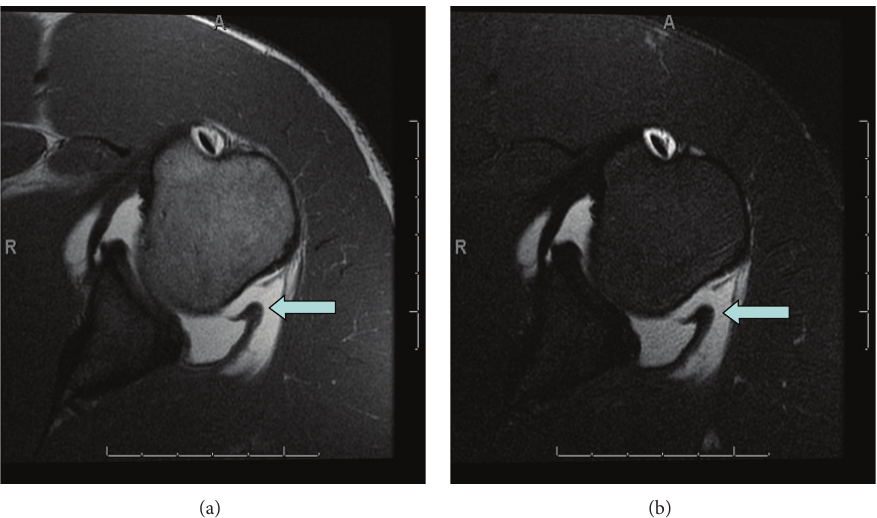
Figure 7: Case 7. Axial T1 and fat saturated T2 images demonstrate posterior band of IGL with thickening and retraction of ligament (arrow) and contrast on both intra- and extra-articular sides of the ligament.